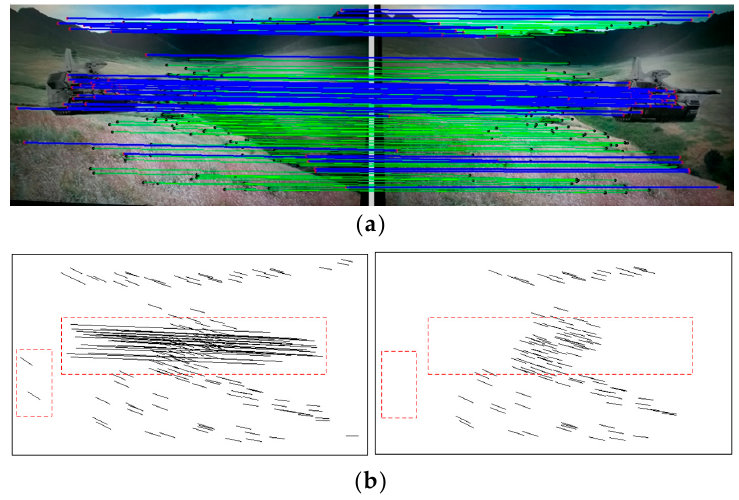
Figure 13. Matching pairs ( a ) and local motion vectors ( b ) for the tank target. Sensors 2016 , 16 , 486